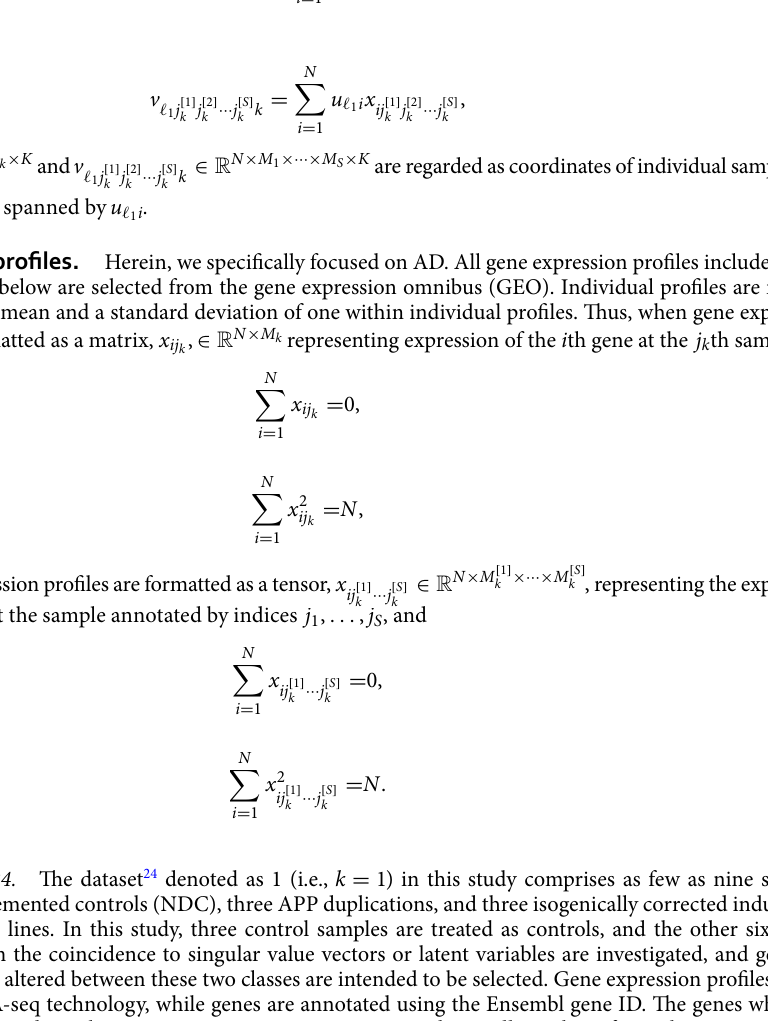
Dataset 2: GSE155567. The dataset 25 denoted as 2 (i.e., k = 2 ) in this study comprises four classes, including THP1 macrophages after the knockout of CD33 and/or the knockdown (silencing) of PTPN6 (six samples per class). Thus, in all, it includes as few as 24 samples. In this study, we do not specifically assume which classes are considered controls, but they are regarded as four categorical classes when the coincidence with singular value vectors or latent variables are investigated. For unknown reasons, although gene expression profiles of one sam- ple are missing, it is unlikely to affect the outcome because it includes almost all (23 out of 24) samples. Gene expression profiles are measured using RNA-seq technology, and genes are annotated using the Ensembl gene ID. The number of genes whose expressions are measured amount to as many as 60,617 in contrast to the small number of samples. As a result, gene expression profiles are formatted as a matrix, x ij 2 ∈ R 60617 × 23 , representing the expression of the i th gene of the j 2 th sample. Dataset 3: GSE162873. The dataset 26 denoted as 3 (i.e., k = 3 ) in this study comprises eight samples, four of which are AD cell lines, and the other four are normal. Because four AD cell lines comprise two sets of two samples using two distinct cell lines, this dataset includes three categorical classes when the coincidence with singular value vectors or latent variables is investigated. Two samples are taken from the first AD cell line, two samples are taken from the second AD cell line, and four samples are taken from normal cell lines. Gene expres- sion profiles are measured by RNA-seq technology, and genes are annotated using the Ensembl gene ID. The number of genes whose expressions are measured amounts to as many as 47,749 in contrast to the small number of samples. As a result, gene expression profiles are formatted as a matrix, x ij 3 ∈ R 47749 × 8 , representing the expression of the i th gene of the j 3 th